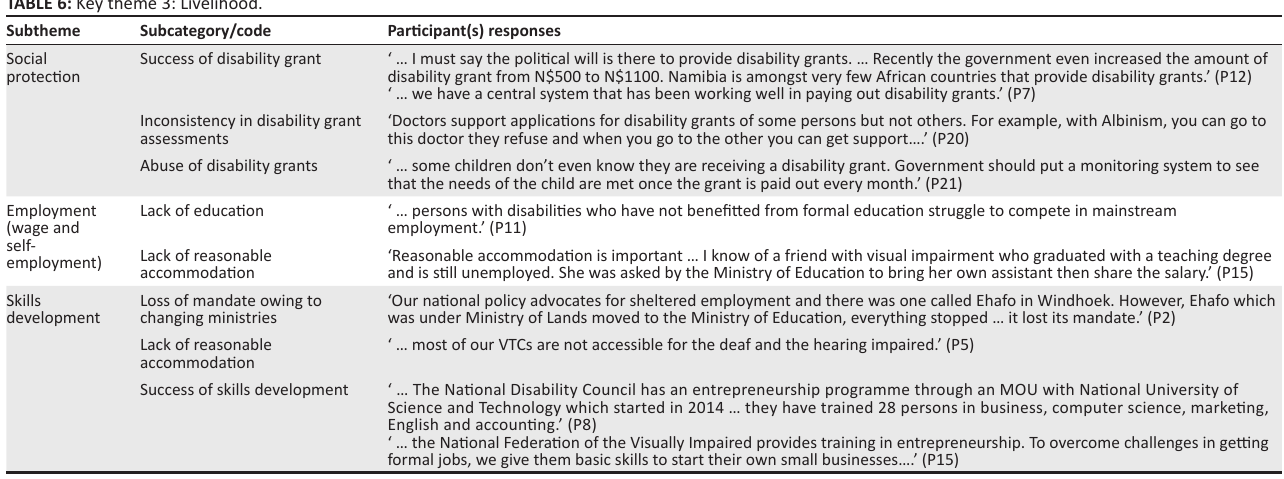
TABLE 6: Key theme 3: